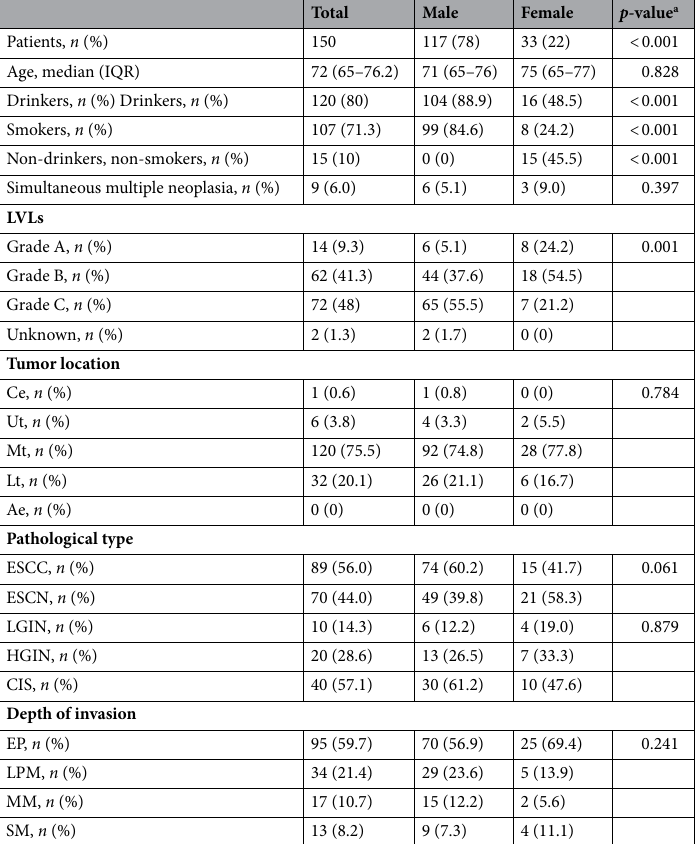
Table 1. Selected characteristics of the patients in the present study. Clinical characteristics at the time of endoscopic treatment Values are expressed as the median (IQR) or number (%). a Comparison of the values between male and female patients was performed using the χ 2 test or Wilcoxon rank-sum test.